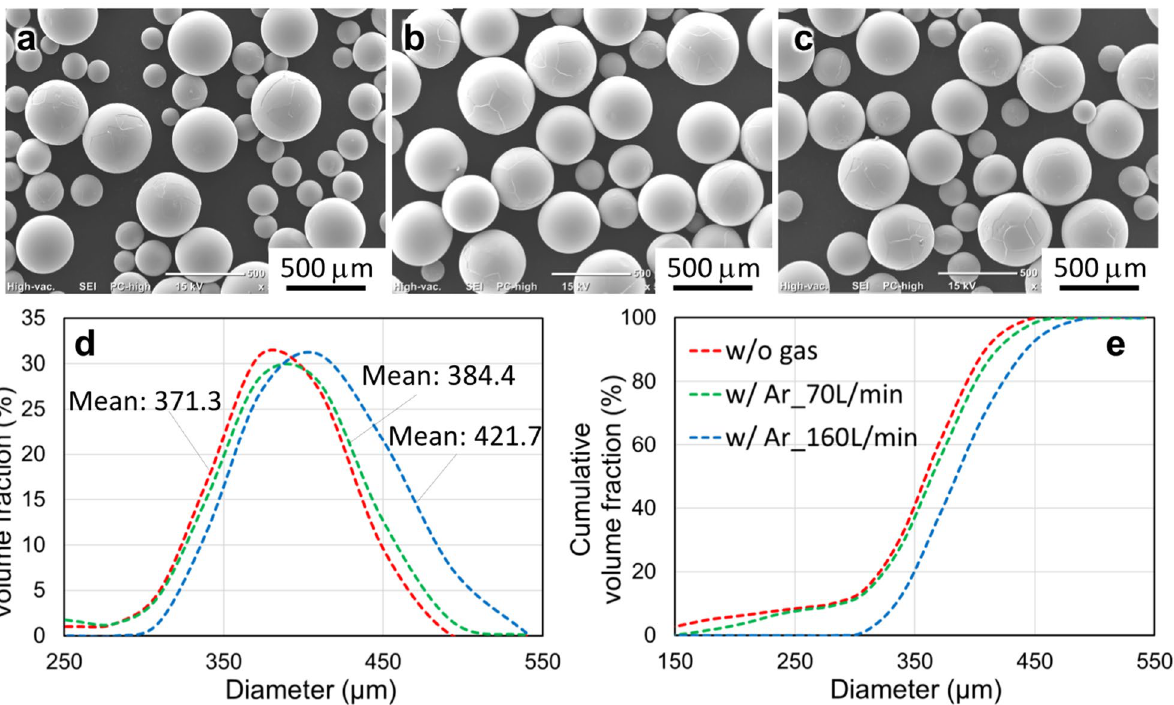
Figure 5. ( a – c ) Ti64 powders and ( d , e ) corresponding PSD fabricated using an electrode with a diameter of 15 mm, at 11,700 rpm and current of 80 A. The flow rates of argon were ( a ) 0, ( b ) 70 and ( c ) 160